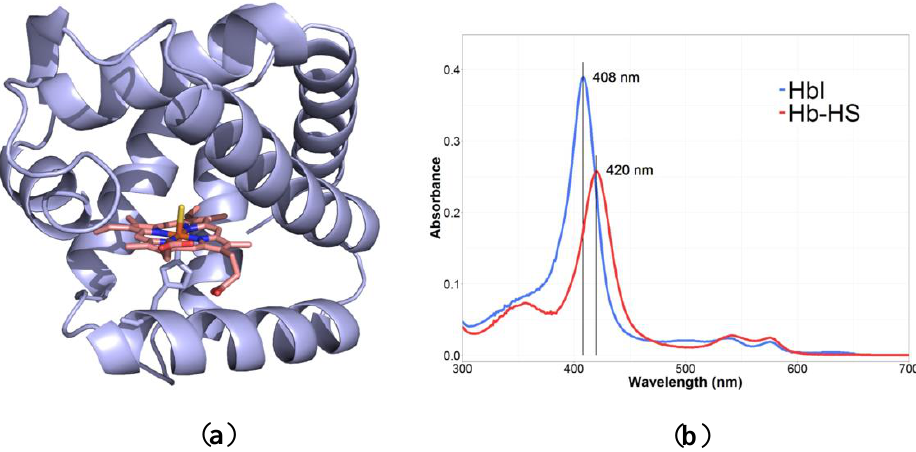
Figure 8. ( a ) Structure of HbI of Lucina pectinata bound to sulfide. ( b ) UV-visible spectra of hemoglobin I (10 µM) before (blue) and after (red) addition of NaHS (1 mM, source of H 2 S) in 0.05 M Tris buffer, pH = 8.6. Formation of the HbI-HS complex results in a red-shift in the UV-visible spectrum from 408 to 420 nm and hypochromy of the Soret band. Absorbance maxima are in agreement with data published in Boffi et al. [158].